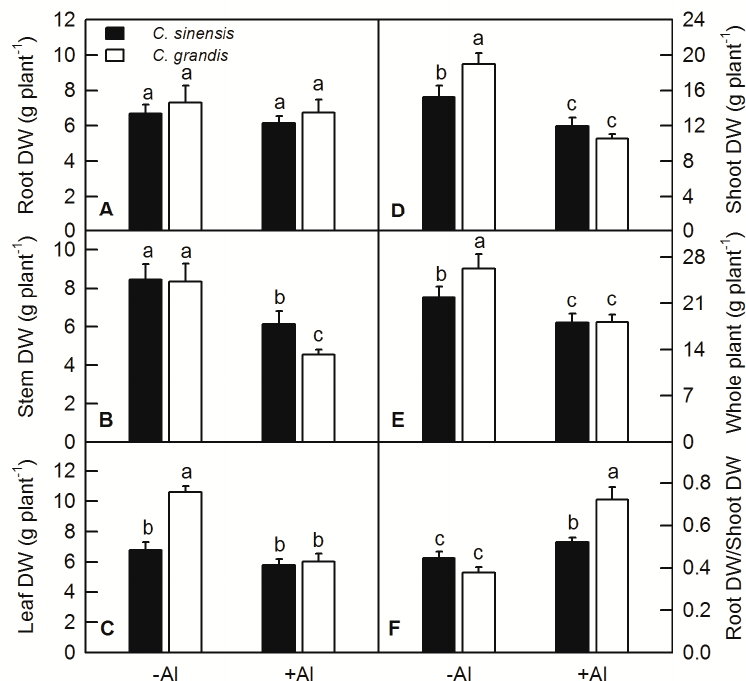
Figure 1. Effects of Al toxicity on dry weight (DW) of root ( A ), stem ( B ), leaf ( C ), shoot (stem + leaf) ( D ) and whole plant ( E ), and the ratio of root to shoot ( F ) in C. sinensis and C. grandis . Bars represent means ± SD ( n = 10). Different letters above the bars indicate a significant difference at p < 0.05.